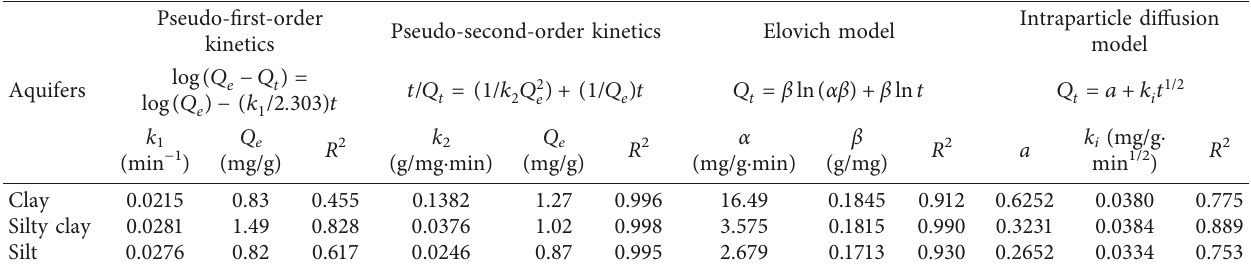
Table 1: Constants and coefficients of kinetic